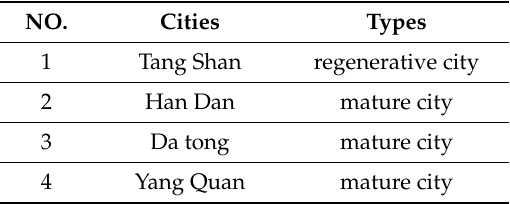
Table A1. Names and Types of 33 Sample